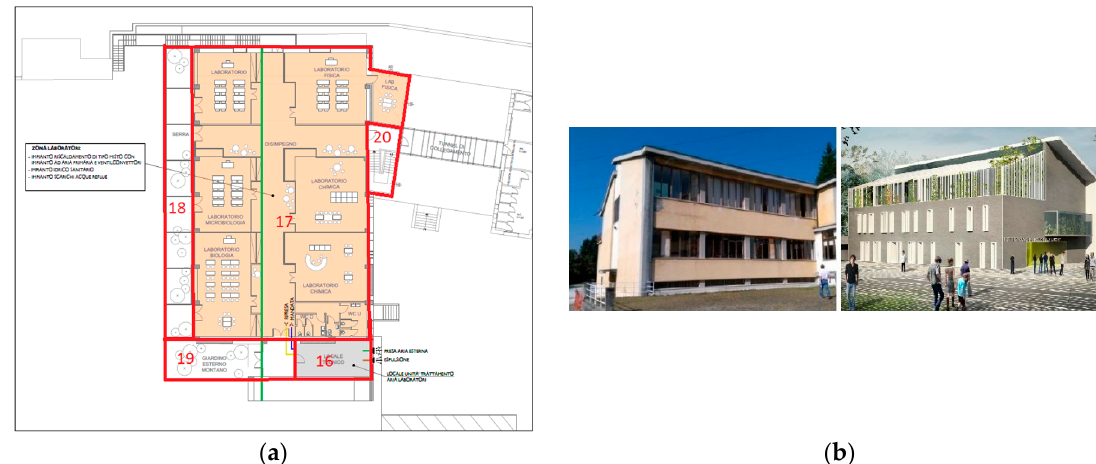
Figure 6. The retrofitting intervention and definition of thermal zones for the second floor ( a ); building as is and post-intervention ( b ).